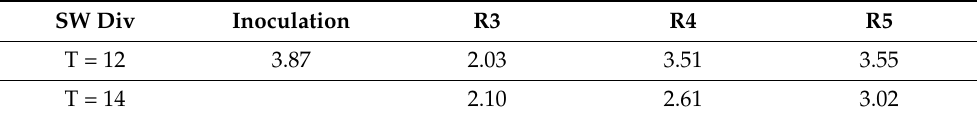
Table 5. Bacterial diversity numeric classification of the inoculum and the three reactors. T = 12 represents the end of the stabilization period and T = 14 the end of the treatment